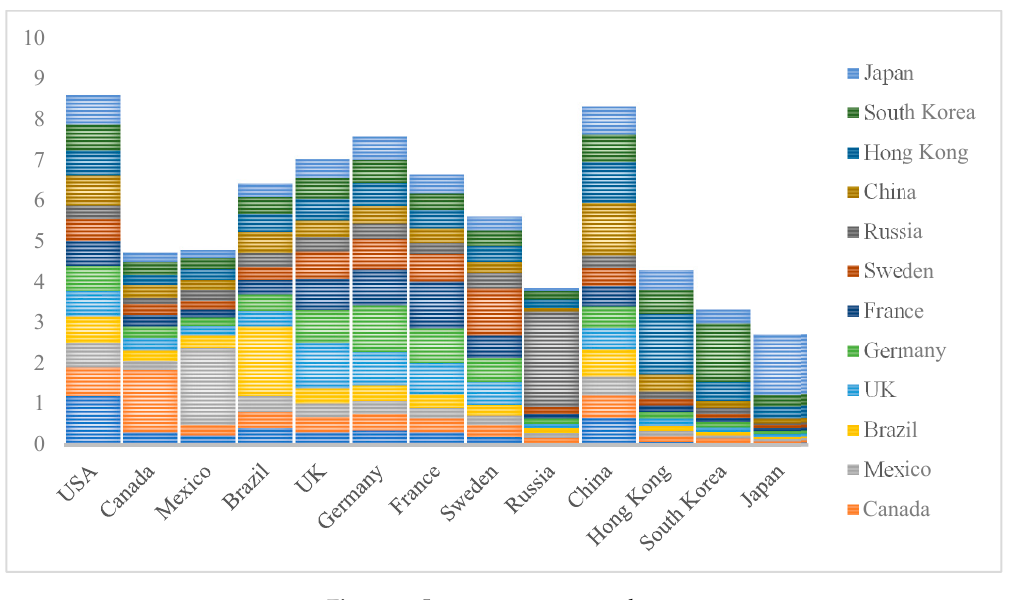
Figure 3. Long-term connectedness.